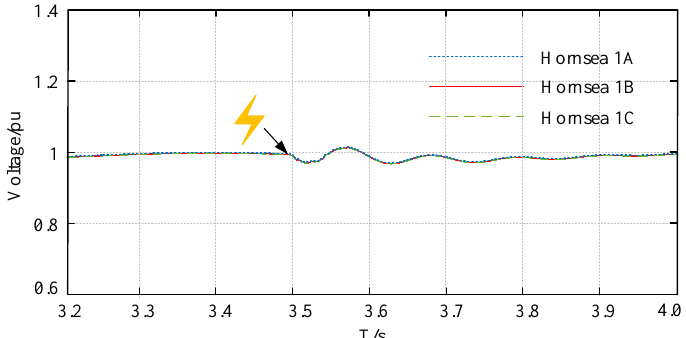
Figure 10. The terminal voltage of each wind turbine. It can be seen that the terminal voltage of Hornsea 1A has not been stabilized in a short time after the Hornsea 1B and 1C are disconnected.